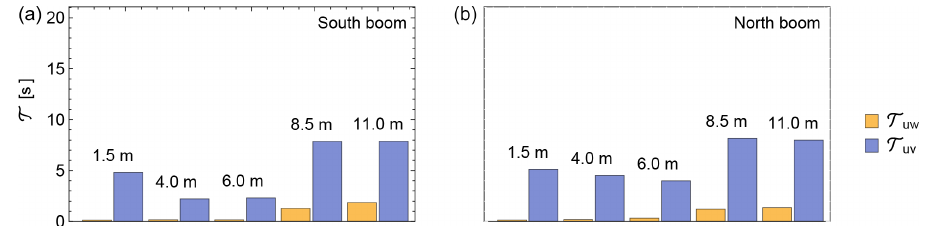
Figure C1. Time integral scale T of (cid:104) u (cid:48) v (cid:48) (cid:105) and (cid:104) u (cid:48) w (cid:48) (cid:105) estimated using the time series of the measurements acquired in each of the 10 sonic anemometers of the M 2 meteorological mast, found on the south (a) and north (b) side of the mast.